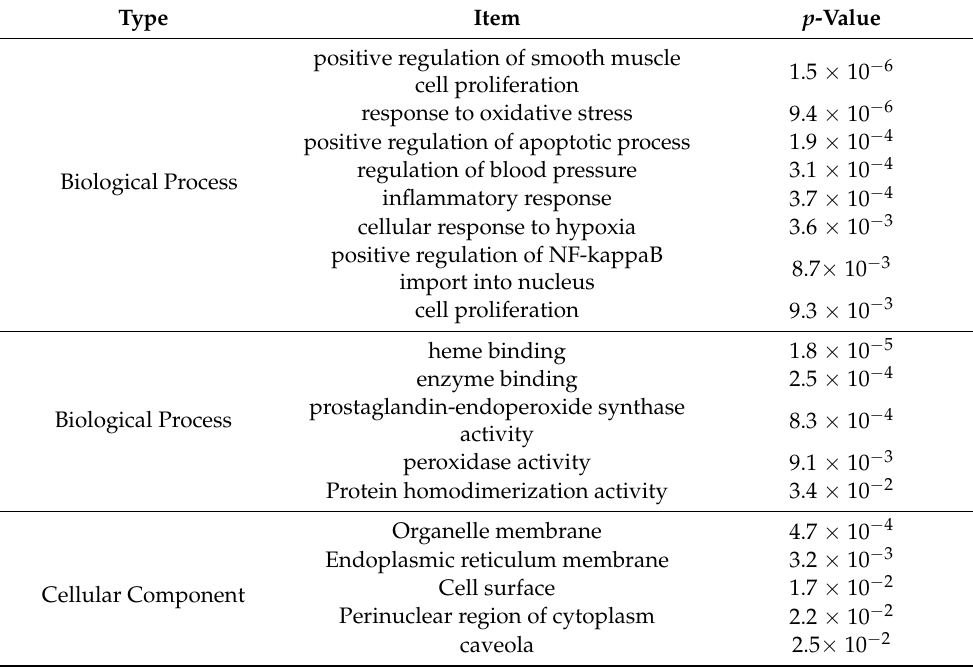
Table 6. The results of GO enrichment